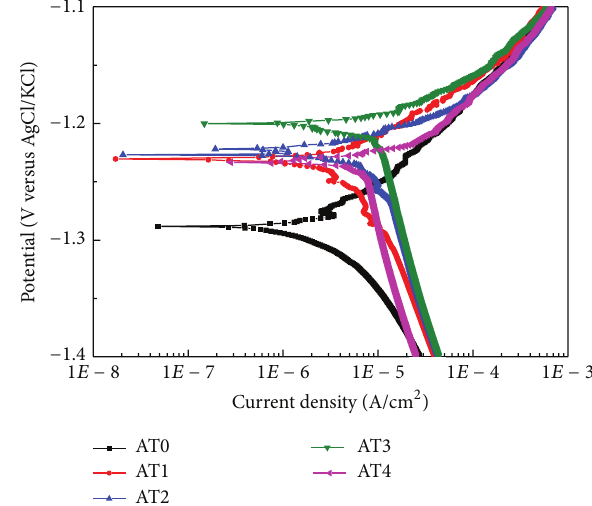
Figure 5: Potentiodynamic polarization curve obtained in HBSS: various heat treated Mg-35Zn-3Ca